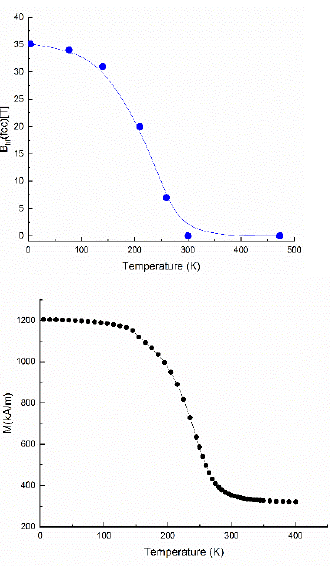
Figure 8. 57 Fe Mössbauer spectra recorded at various temperatures for the sample annealed at 700 °C.